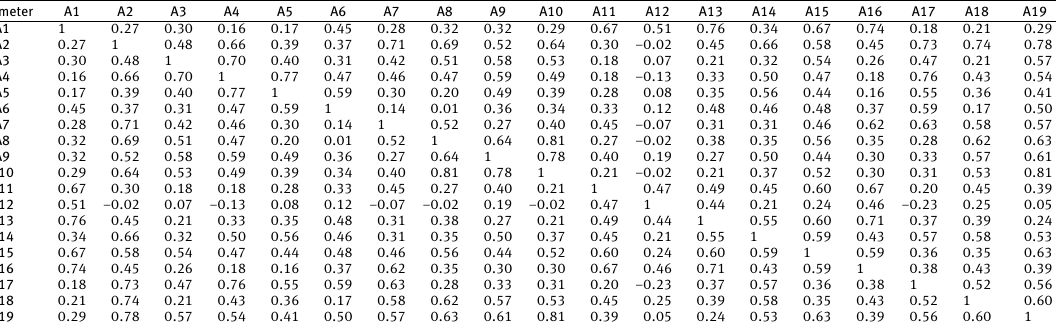
Table 7: Empirical correlations between log losses in adjacent areas. Parameter